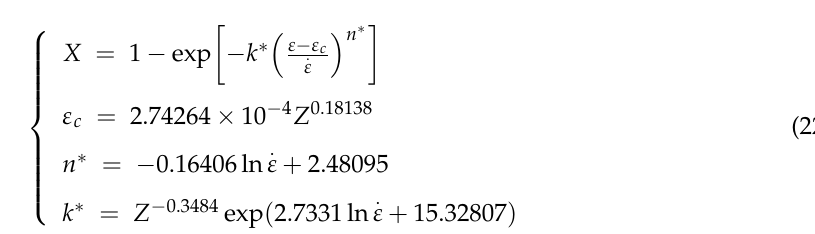
Figure 10. The relationship between the Z parameter and k ∗ . These linear curves are obtained from the linear fitting of points with the same strain rates. Here, the Z parameter is in the form of Z = ε exp ( 383094/ ( 8.31 T )) . Insert: the relationship between fitting linear fitting curves.